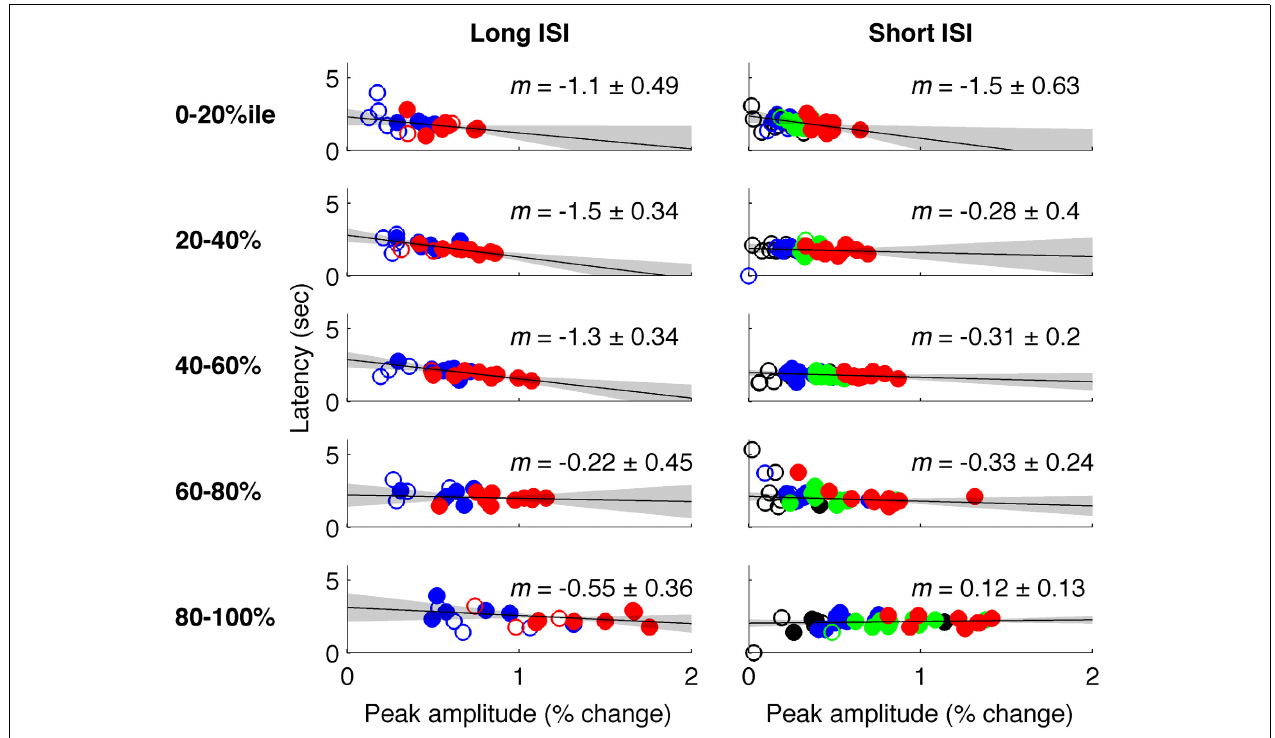
FIGURE 6 | Latency vs. amplitude when voxels are binned by mean-normalized variance. Left : Experiment 1 (short-ISI); Right : Experiment 2 (long-ISI). Each row represents 20% of voxels, selected according to variance in signal amplitude divided by mean amplitude. Top row : The 20% of voxels with lowest mean-normalized variance. Second row: the second quintile of voxels sorted according to mean-normalized